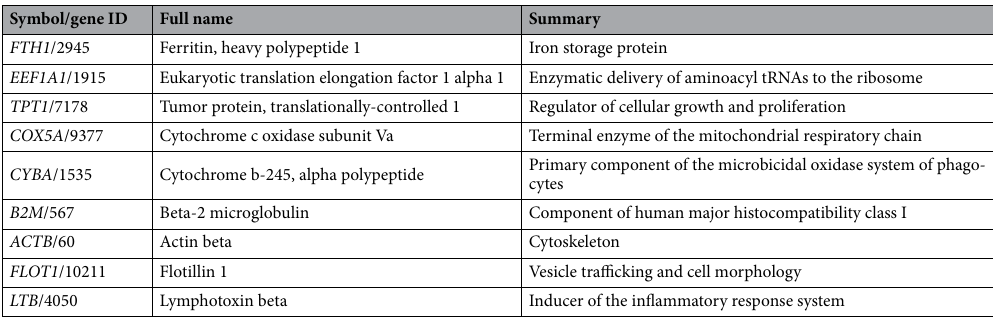
Table 1. The genes obtained commonly from both yeast two-hybrid library screenings using FL- and C-pyrin